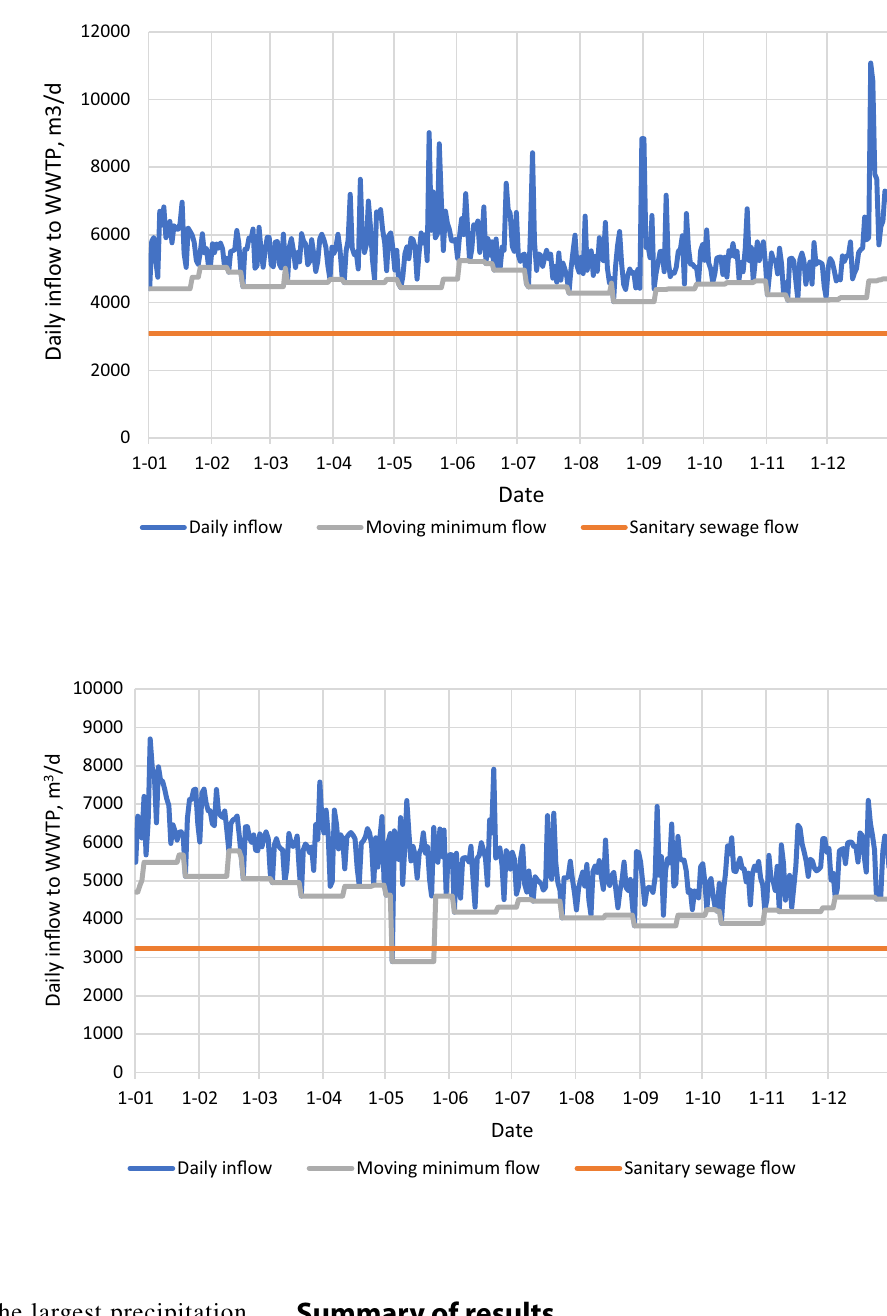
Fig. 8 Moving minimum flow plotted on a daily inflow dia- gram in the year 2014